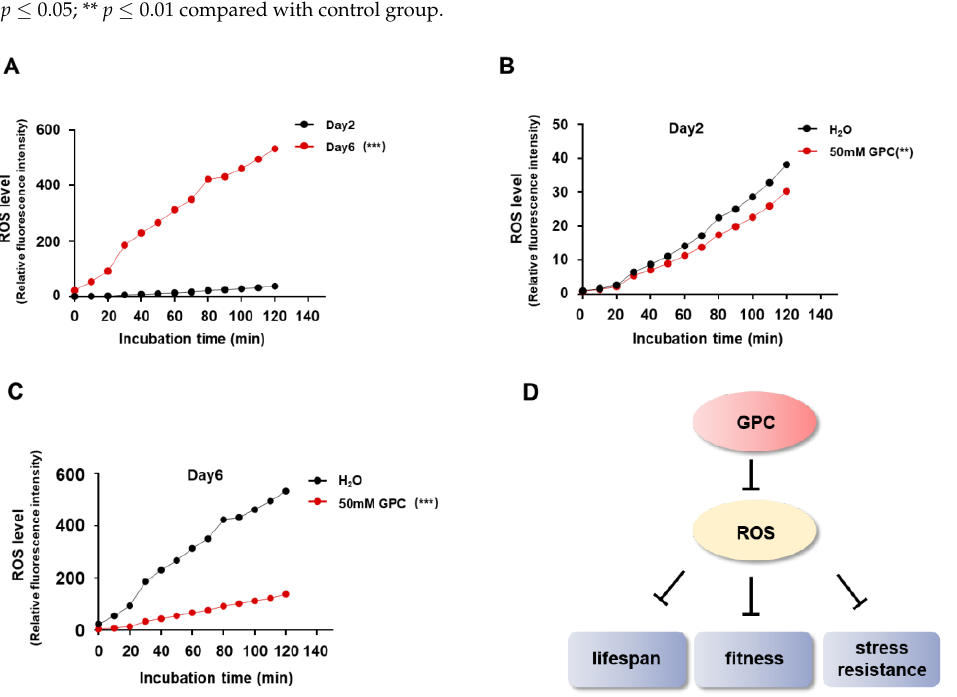
Figure 6. GPC reduces ROS accumulation in C. elegans with age. ( A ) The level of intracellular ROS increased during aging. In total, 500 nematodes on day 2 and day 6 of adulthood were harvested and measured for ROS levels with the fluorescent dye DCF. The fluorescence intensity was measured every 10 min for 2 h at 37 °C. ( B , C ) GPC inhibited ROS accumulation in C. elegans on day 2 ( B ) or day 6 ( C ). Nematodes on day 2 or day 6 of adulthood treated with or without GPC were harvested and ROS level was detected as in ( A ). ( D ) Illustration of GPC function in promoting lifespan and healthspan. ** p < 0.001; *** p < 0.0001; by two-way analysis of variance (ANOVA) followed by Bonferroni tests. Values are mean ± s.e.m.